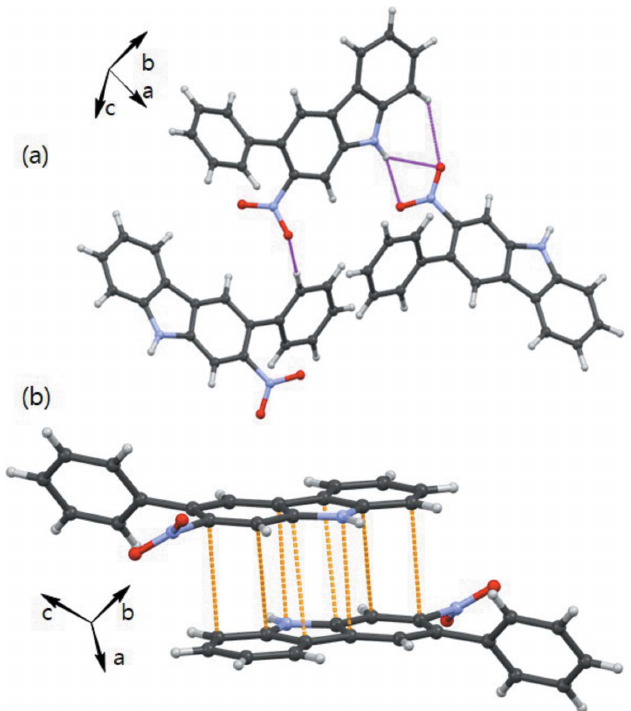
Figure 2 A plot showing ( a ) the intermolecular N—H (cid:2)(cid:2)(cid:2) O, C—H (cid:2)(cid:2)(cid:2) O hydrogen bonds and ( b ) (cid:2) – (cid:2) interactions.